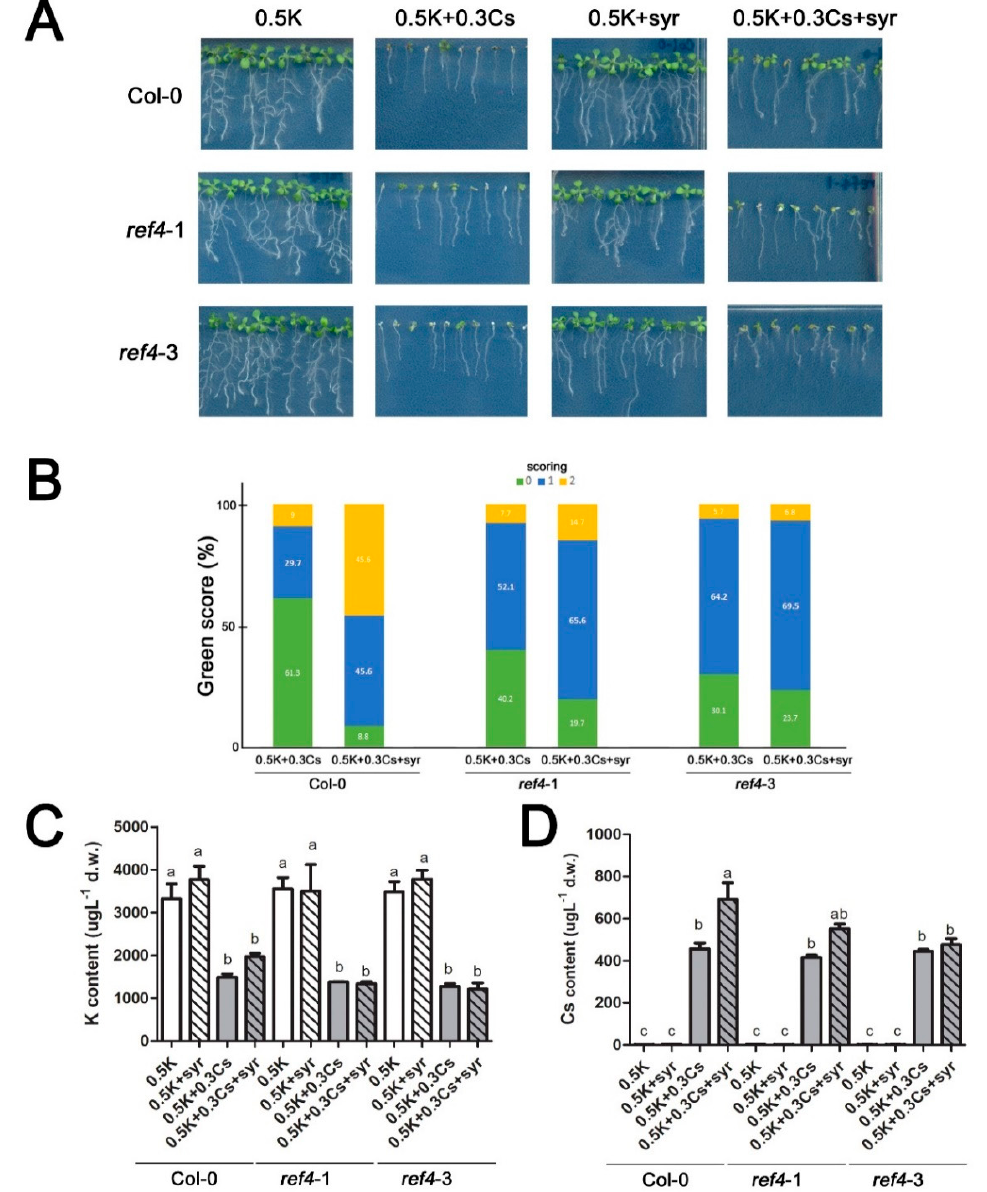
Figure 5. The absence of REF4 expression negates the e ff ect of syringic acid on the alleviation of cesium-induced growth retardation. ( A ) Two Arabidopsis REF4 mutants ( ref4 -1 and ref4 -3) were grown on media containing 0.5 mM potassium (K) and 0.3 mM cesium (Cs) with or without the addition of 100 µ M syringic acid (syr). ( B ) Percentile green scores (left axis and numbers inside of bars) for ref4 mutants and Col-0 treated with 0.5 mM K and 0.3 mM Cs with or without the addition of 100 µ M syringic acid (syr) ( n > 72). All of the seedlings used for the green scoring were also analyzed for potassium ( C ) and cesium ( D ) quantification. Statistically significant di ff erences between treatment groups were determined by a one-way ANOVA with Bonferroni’s multiple comparison post-test and are indicated with di ff erent letters ( p < 0.05). Error bars represent the